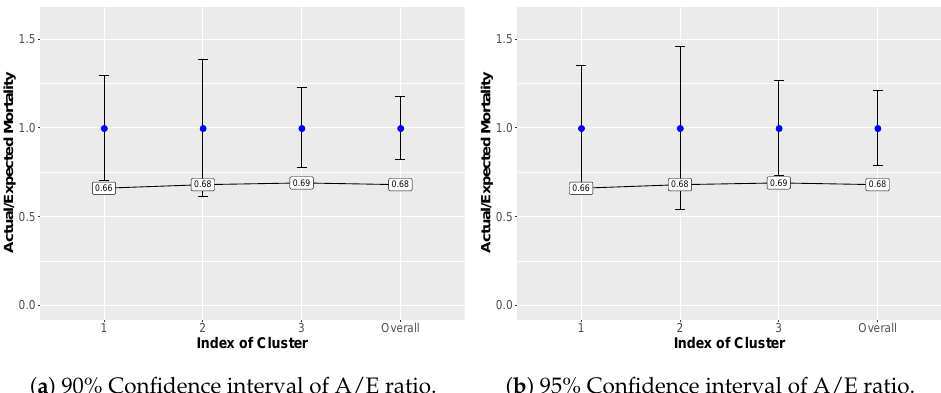
Figure 6. Actual to expected mortality rates based on face amounts. The values in the boxes are the observed ratios for the respective clusters; the confidence intervals were calculated based on the theory developed in Appendix